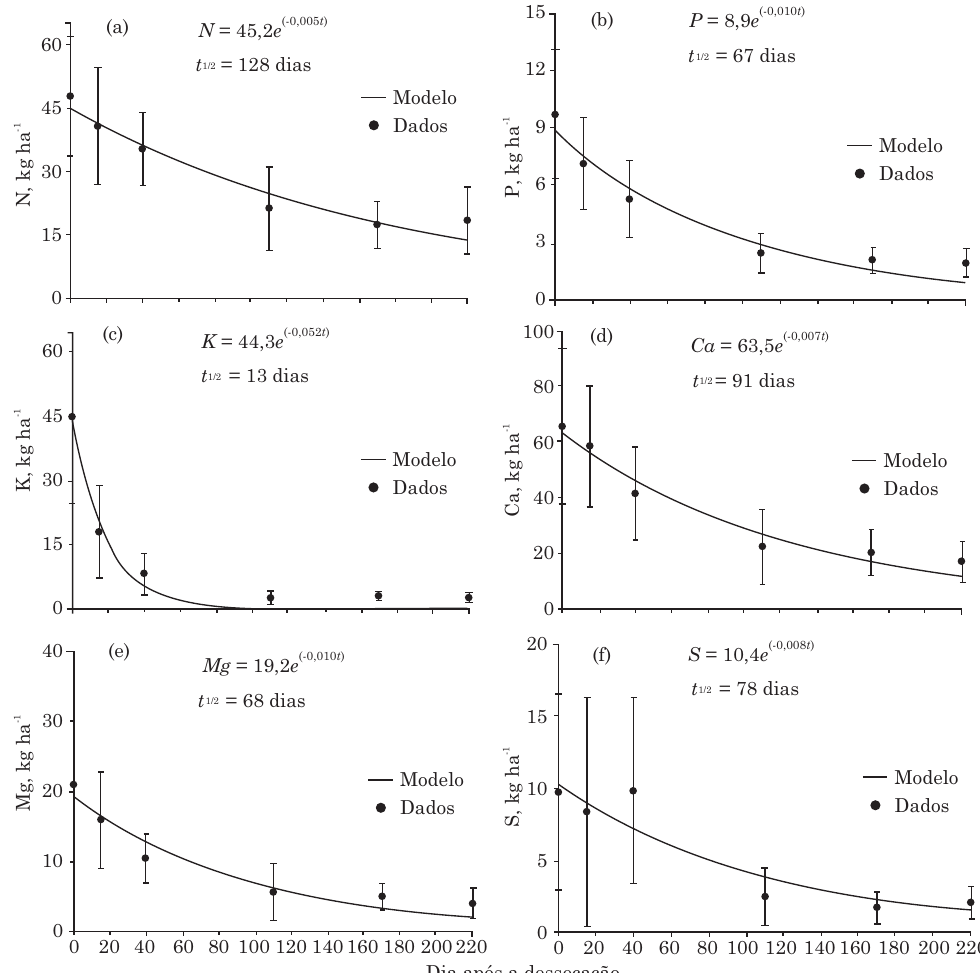
Figura 3. Liberação de nitrogênio (a), fósforo (b), potássio (c), cálcio (d), magnésio (e) e enxofre (f) da palhada de milho + Brachiaria ruziziensis após a desseção da área com herbicida. Barras verticiais representam o desvio-padrão da média de cada